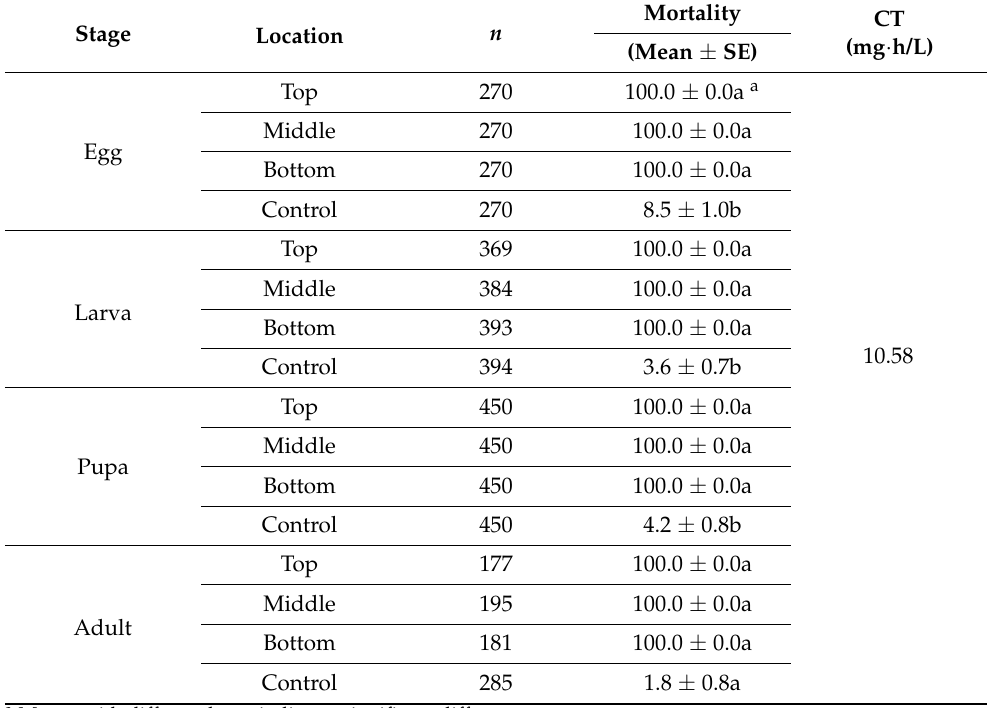
Table 3. Mortality of D . suzukii at each location exposed to cold treatment (1 ◦ C, 24 h) after PH 3